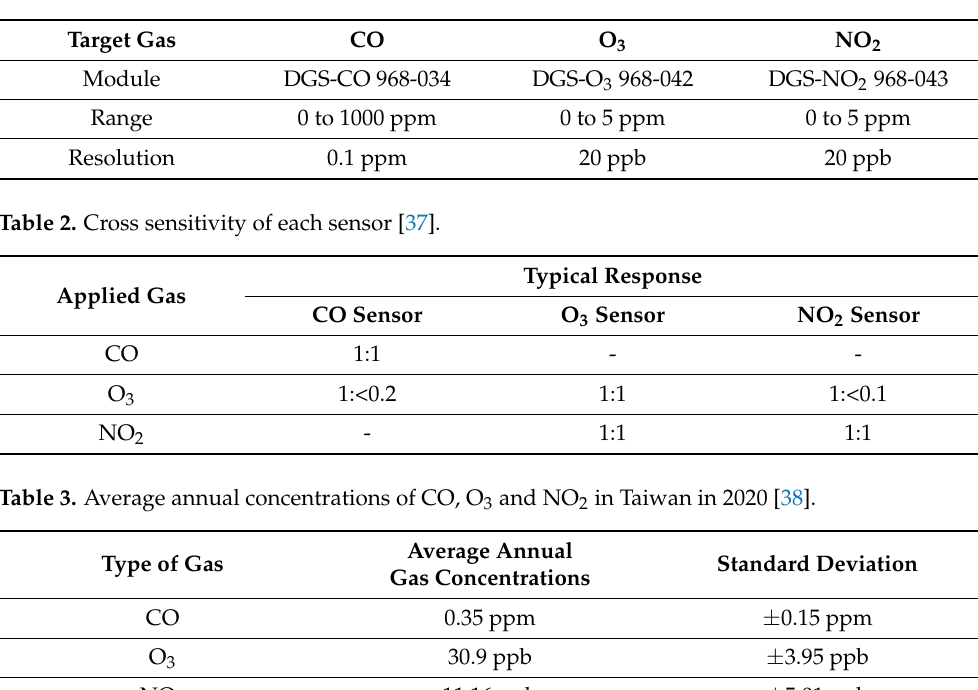
Table 1. Performance characteristics of each sensor [37].